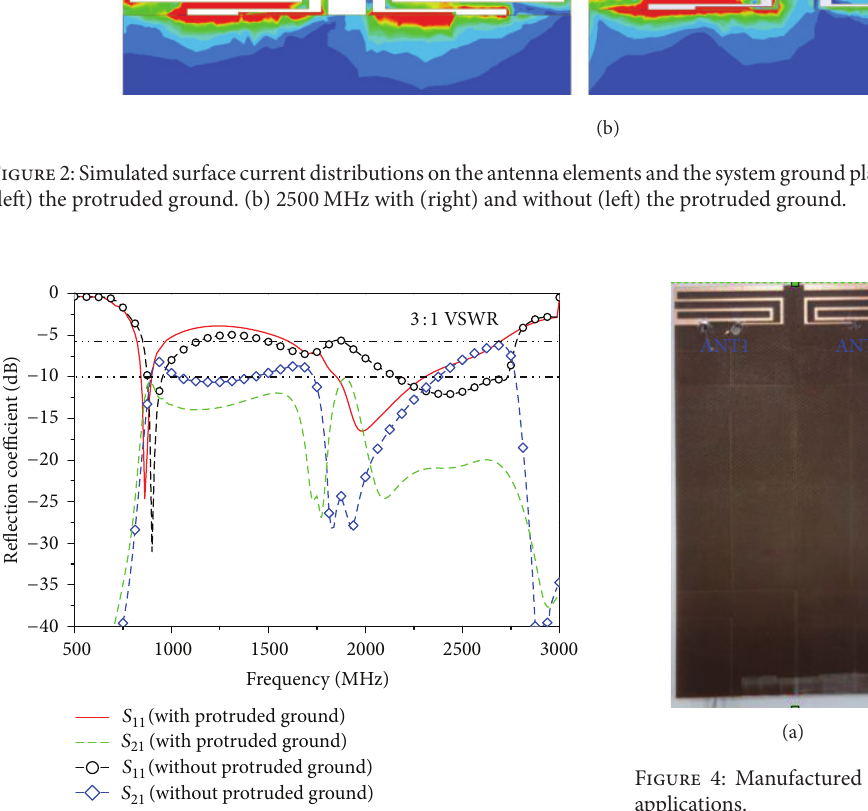
Figure 3: Simulated 𝑆 parameters with and without the protruded ground for the antenna array.